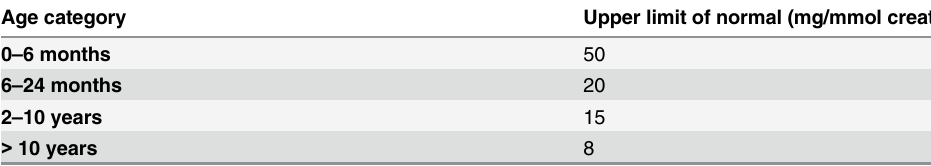
Table 3. Upper limit of normal for DMB per age